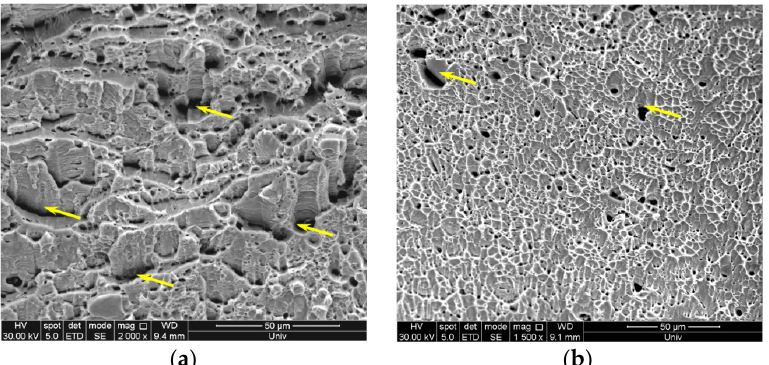
Figure 5. Scanning electron micrograph of the fracture morphology of the steel annealed at ( a ) 800 ◦ C and ( b ) 1000 ◦ C. Yellow arrows indicate the quasi-cleavage fracture